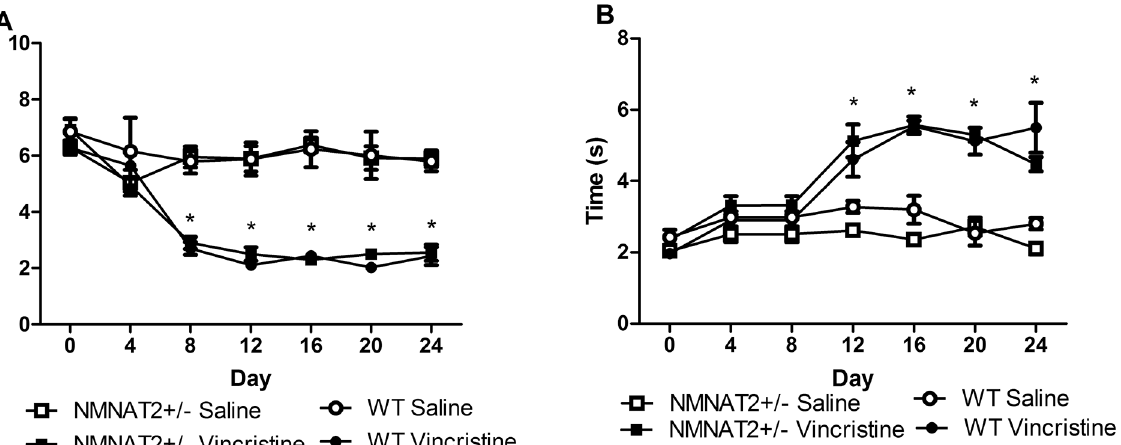
Fig 4. Vincristine-induced mechanical and cold allodynia did not differ between NMNAT2+/- and WT mice. There were no differences between genotypes in the development or maintenance of vincristine-induced mechanical hypersensitivity (A) or cold allodynia (B). Data are expressed as mean ± SEM (NMNAT2+/- vehicle n = 8, NMNAT 2+/- vincristine = 9, WT Vehicle = 5, WT vincristine = 6) * p < .05 vs. control, one-way analysis of variance followed by Bonferroni post hoc